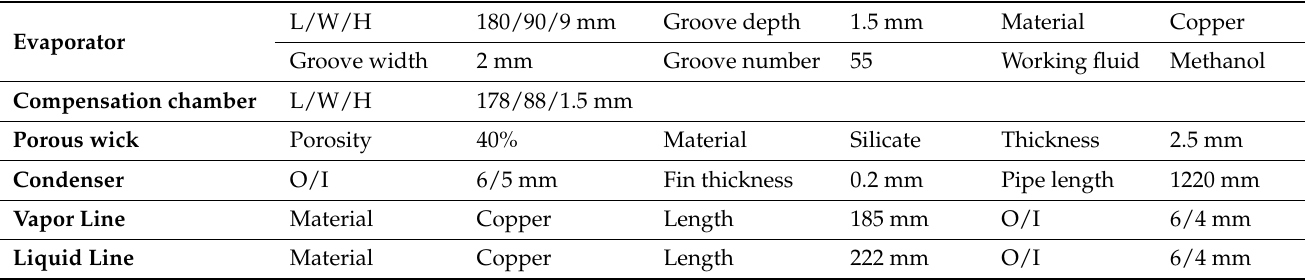
Table 1. Parameters of the LHP.